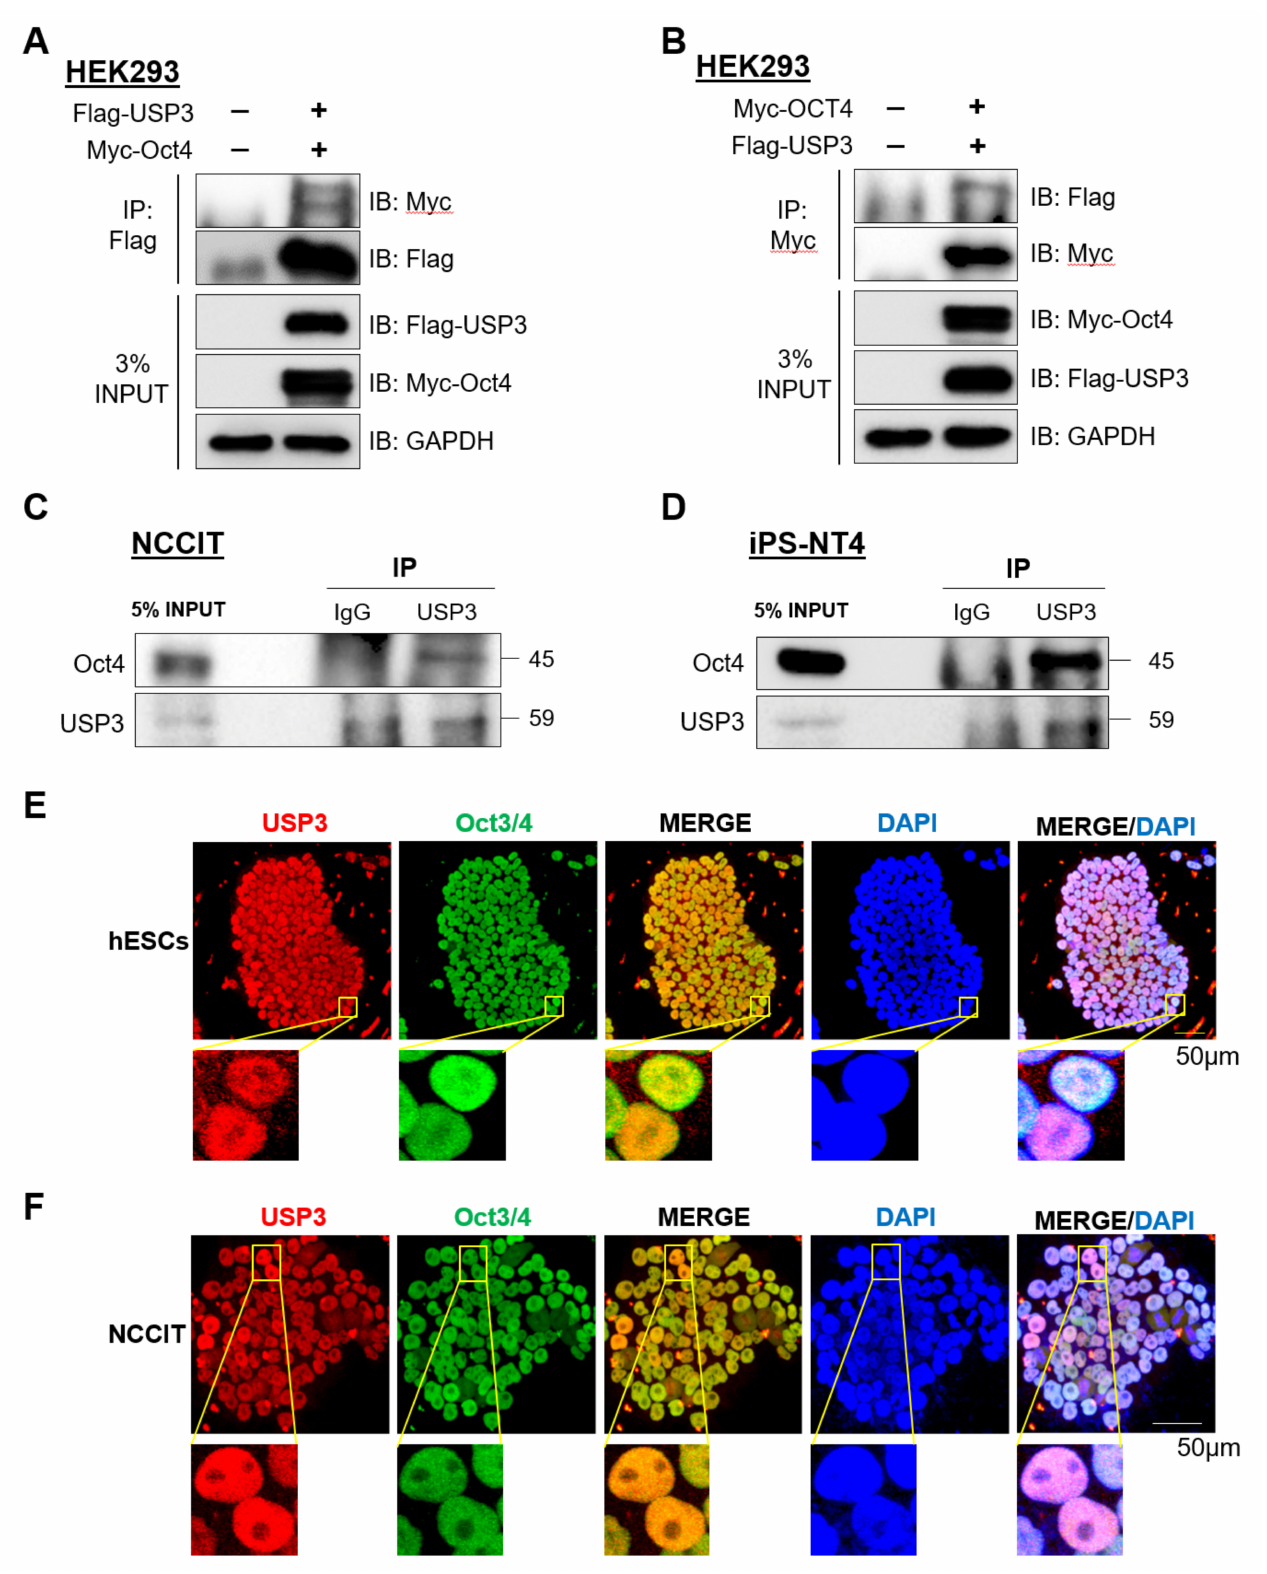
Figure 3. USP3 interacted and co-localized with Oct4. Exogenous immunoprecipitation (IP) was performed by co- transfecting Flag-USP3 and Myc-Oct4 into HEK293 cells. ( A ) IP was performed using anti-Flag antibody and immunoblotted using anti-Myc antibody. GAPDH was used as a loading control. ( B ) IP was performed using anti-Myc antibody,